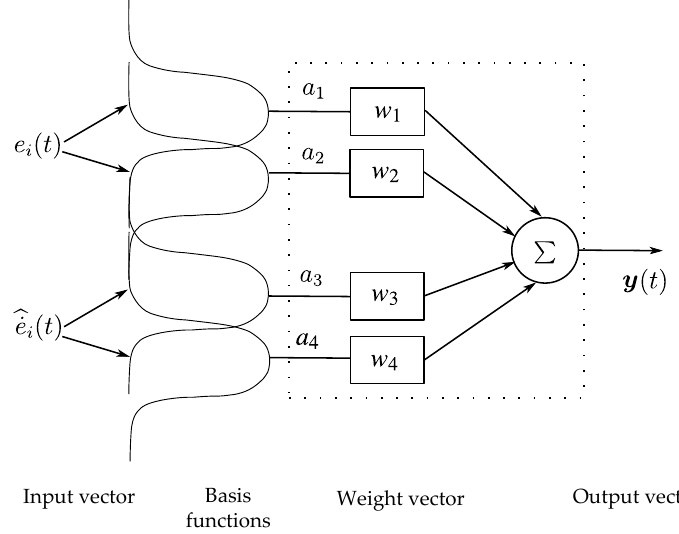
Figure 2. Three layer B-spline artificial neural network structure,